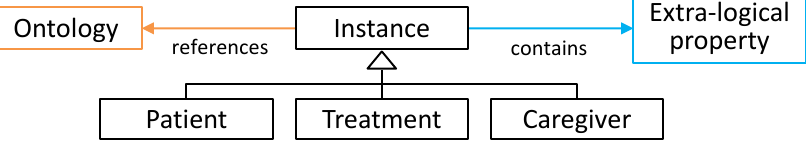
Figure 3. Knowledge